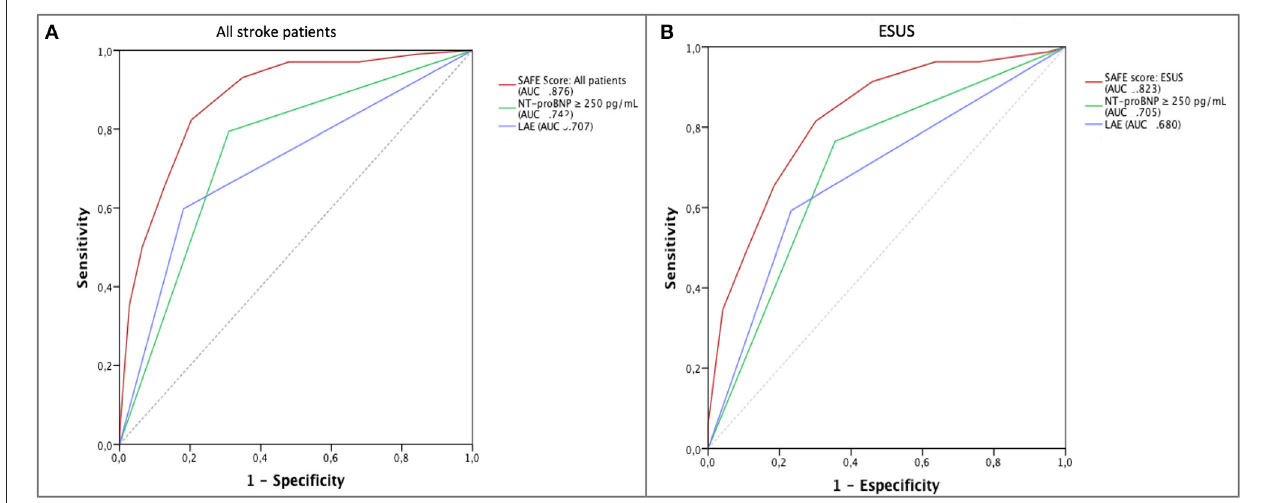
FIGURE 2 | AF prediction by SAFE. (A) Prediction of new-onset AF by the SAFE scores (AUC 0.876), compared to NT-proBNP levels (AUC 0.742) and left atrial enlargement (AUC 0.707) for all stroke-patients, p < 0.05. (B) Prediction of new-onset AF by the SAFE scores (AUC 0.823), compared to NT-proBNP levels (AUC 0.705) and left atrial enlargement (AUC 0.680) for stroke-patients meeting the ESUS criteria after 24h cardiac monitoring, p < 0.05. AF, atrial fibrillation; AUC, area under the curve; ESUS, Embolic stroke of undetermined source; LAE, left atrial enlargement; NT-proBNP, N-terminal prohormone of brain natriuretic peptide; SAFE, screening for atrial fibrillation